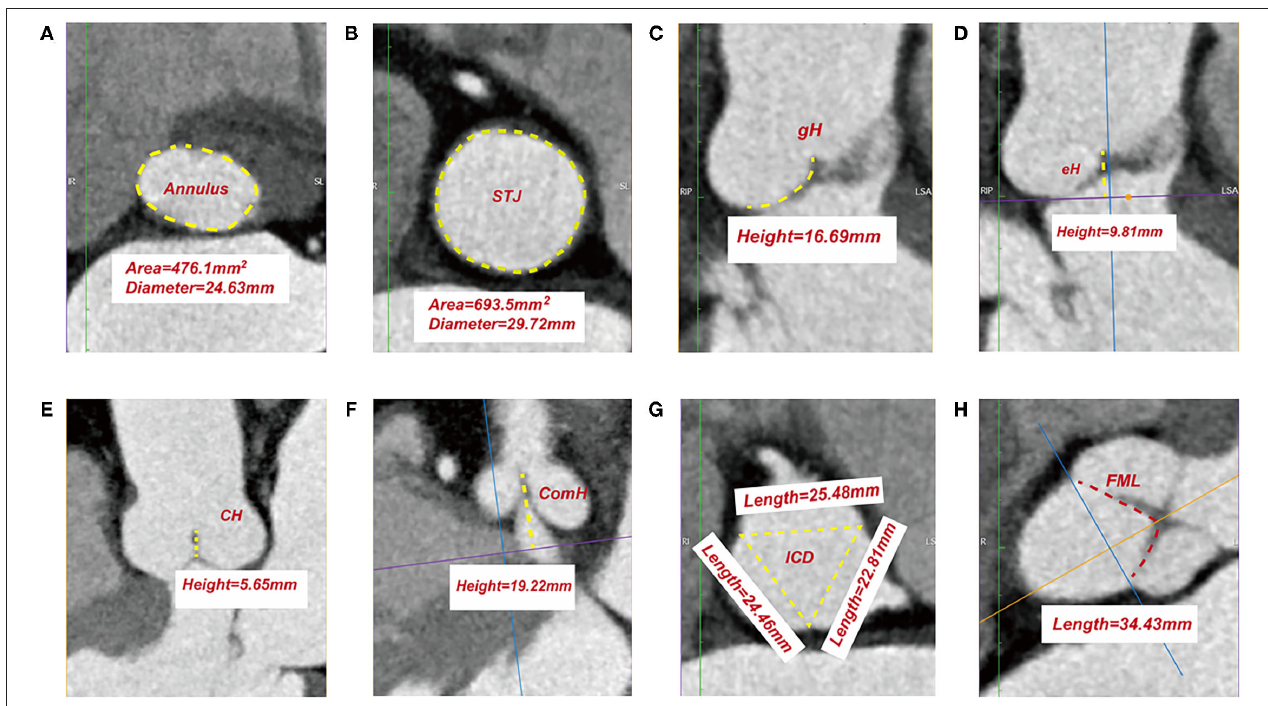
FIGURE 1 | Measurements of leaflet and root parameters in normal aortic valve by three-dimensional reconstruction of ECG-gated computed tomography. Surface area and diameter of annulus (A) . Surface area and diameter of sino-tubular junction (B) . Measurement of geometric height (C) . Measurement of effective height (D) . Measurement of coaptation height (E) . Measurement of commissure height (F) . Measurement of inter-commissural distance (G) . Measurement of free margin length (H) . STJ, sino-tubular junction; gH, geometric height; eH, effective height; CH, coaptation height; ComH, commissure height; ICD, inter-commissural distance; FML, free margin